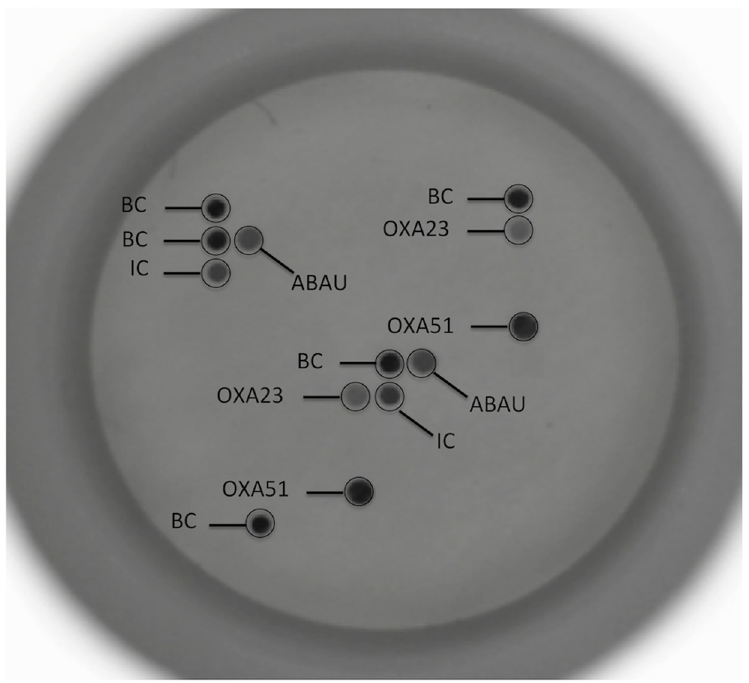
Fig 1. Sepsis Flow Chip device. Multi Drug Resistant A . baumannii carbapenemase producerstrain analyzedby SFC assay. All target probesare by duplicateon the array and a result is consideredas positive result if both signalsare detected. Positive probes detected: Biotin Control(BC), Inner Control(IC), A . baumannii (ABAU), blaOXA-23 (OXA23) and blaOXA-51 (OXA51). The image is enlargedx10 regardingthe actual size of the